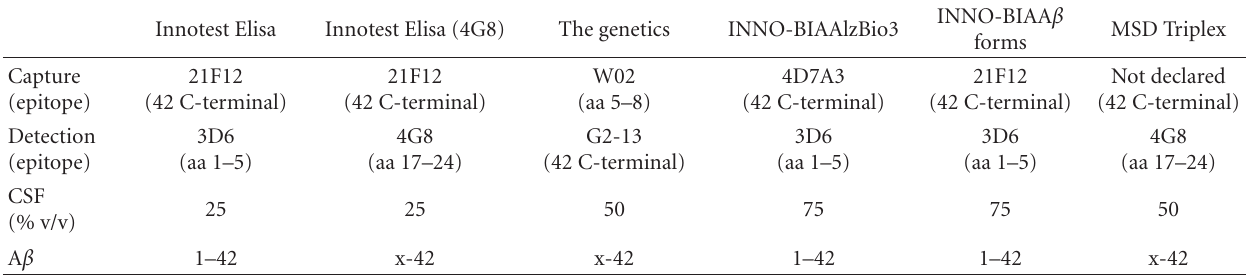
Table 1: Properties of evaluated commercially available A β assays. The various capture and detection antibodies employed in the di ff erent A β 42 immunoassays. The di ff erences in antibody epitope recognition and the part of CSF diluted in bu ff er during the incubation render methodological di ff erences both qualitatively and quantitatively. aa, amino